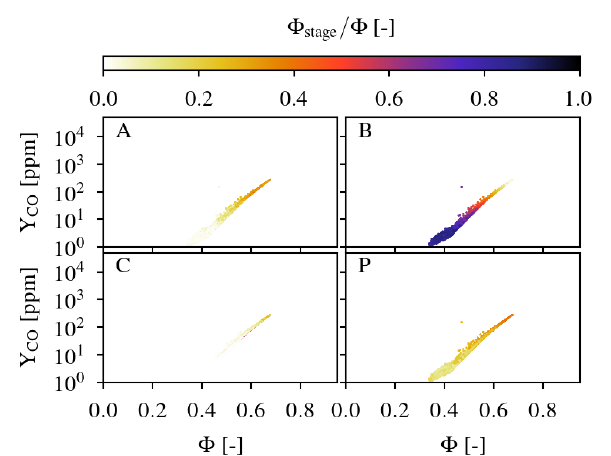
Figure A2. Carbon monoxide mass fraction Y CO over equivalence ratio Φ in dependency of the respective stage equivalence ratio Φ stage normalized by the equivalence ratio for case 1C.